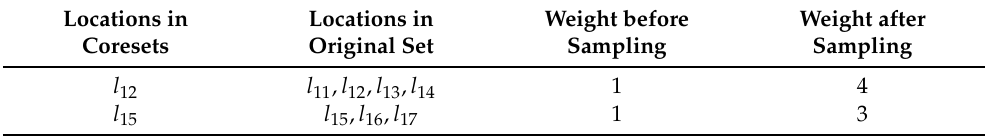
Figure 2. Construction of coresets. An original set of locations (circles and triangles on the left rectangle) and its coreset (bold circle and triangles on the right rectangle) are shown in Figure 2. The elements l 12 and l 15 in the coreset are the corresponding representations of the original set: l 12 represents the locations l 11 , l 12 , l 13 , l 14 , and l 15 represents the locations l 15 , l 16 , l 17 . Table 1. Construction of coresets in Figure 2.